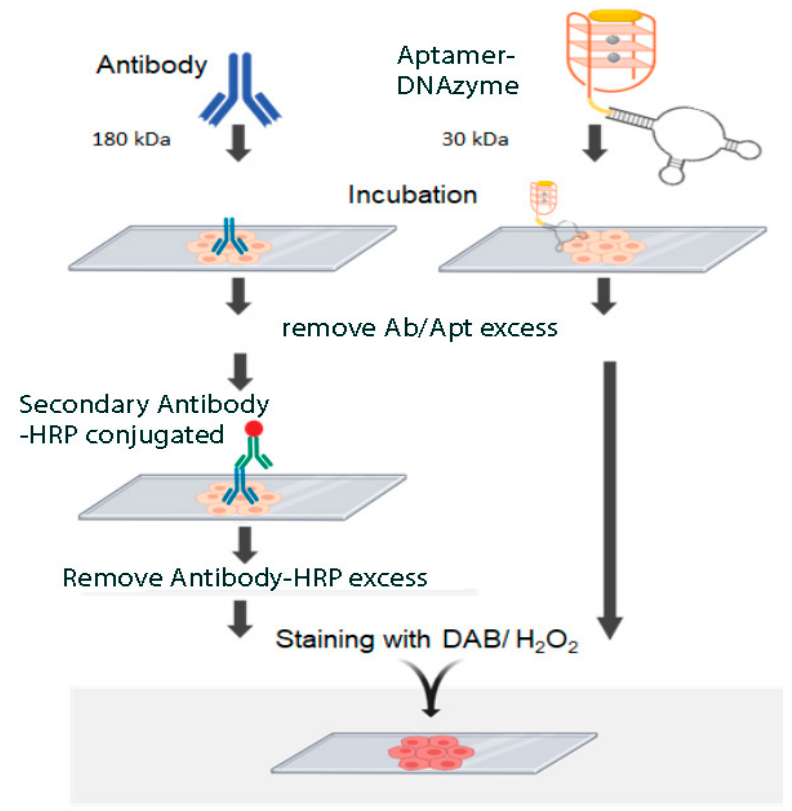
Figure 5. Comparison of immunohistochemistry with antibodies and histochemistry with Aptamer- DNAzyme